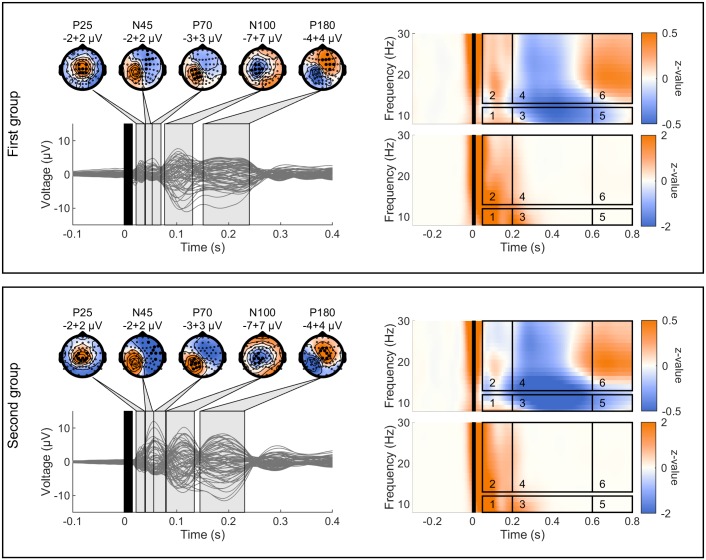
Selection of TEPs TOIs and channels and induced and evoked oscillations ROIs.On the left, single EEG channel traces and topographical plots resulting from the average across all subjects, test blocks and sessions for the first (top) and second (bottom) group of subjects. TEPs peaks are named according to their approximate latency after TMS application. Topographical distributions are obtained averaging the signal in the grey-shaded time windows. The maximum and minimum voltages are reported in μV below the relative topographies. Black filled dots in the topographies indicate the channels where the corresponding TEP peak was maximally expressed and that were used for calculation of LMFP in the relative TOI. On the right side, TFRs of induced (upper part) and evoked (lower part) oscillations on channel C3 averaged across all subjects, test blocks and sessions for the first (top) and second (bottom) group of subjects. Time-frequency ROIs used for the analysis are enclosed by the black rectangles. In all plots, time windows highlighted in black indicate signal affected by TMS-related artifacts that was removed and interpolated.